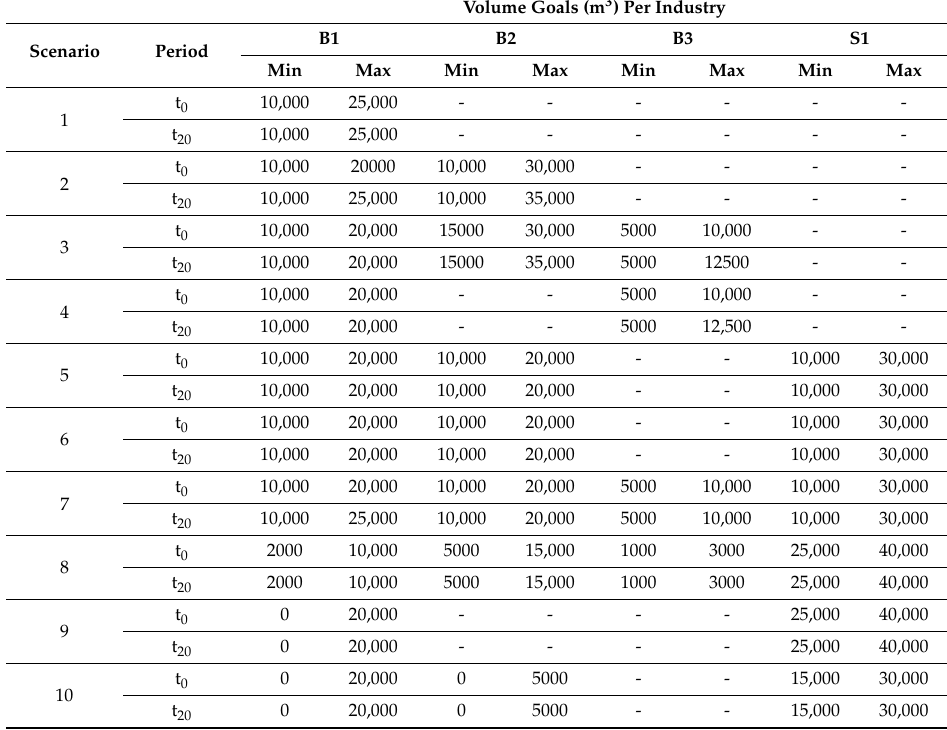
Table A5. Minimum and maximum adjusted volume goals per scenario and industry. Scenarios are those selected as viable in the previous